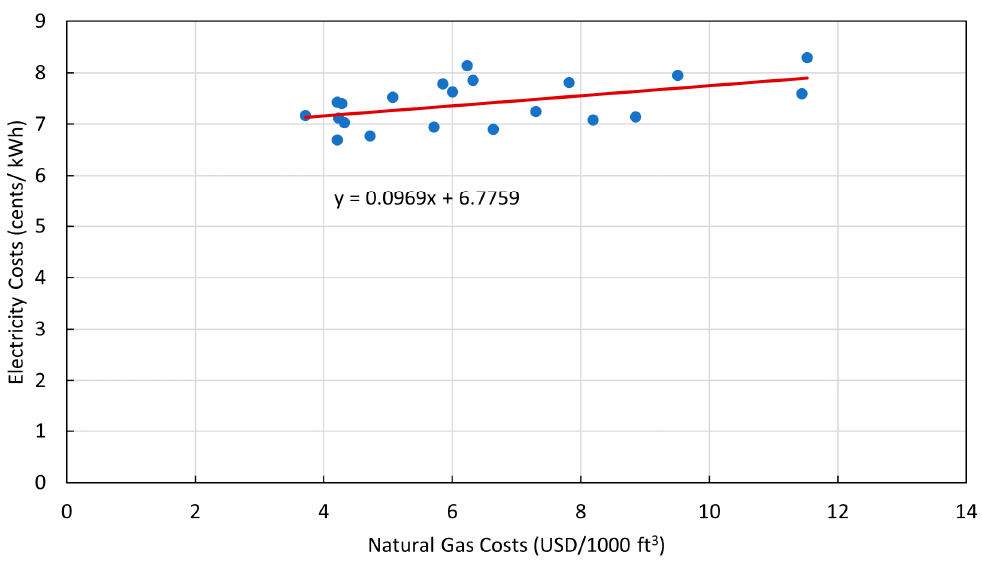
Figure A1. Costs comparison of the average United States industrial electricity and natural gas (USD kWh − 1 ) 1999–2019.